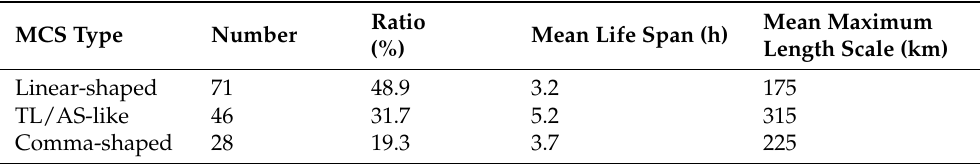
Table 3. The number, percentage (%), mean lifespan (hours) and mean maximum length scale (km) of three MCS types associated with the 58 WSHR events. Mean Maximum Ratio Mean Life Span (h) MCS Type Number Length Scale (km) (%) Linear-shaped 71 48.9 3.2 175 TL/AS-like 46 31.7 5.2 315 Comma-shaped 28